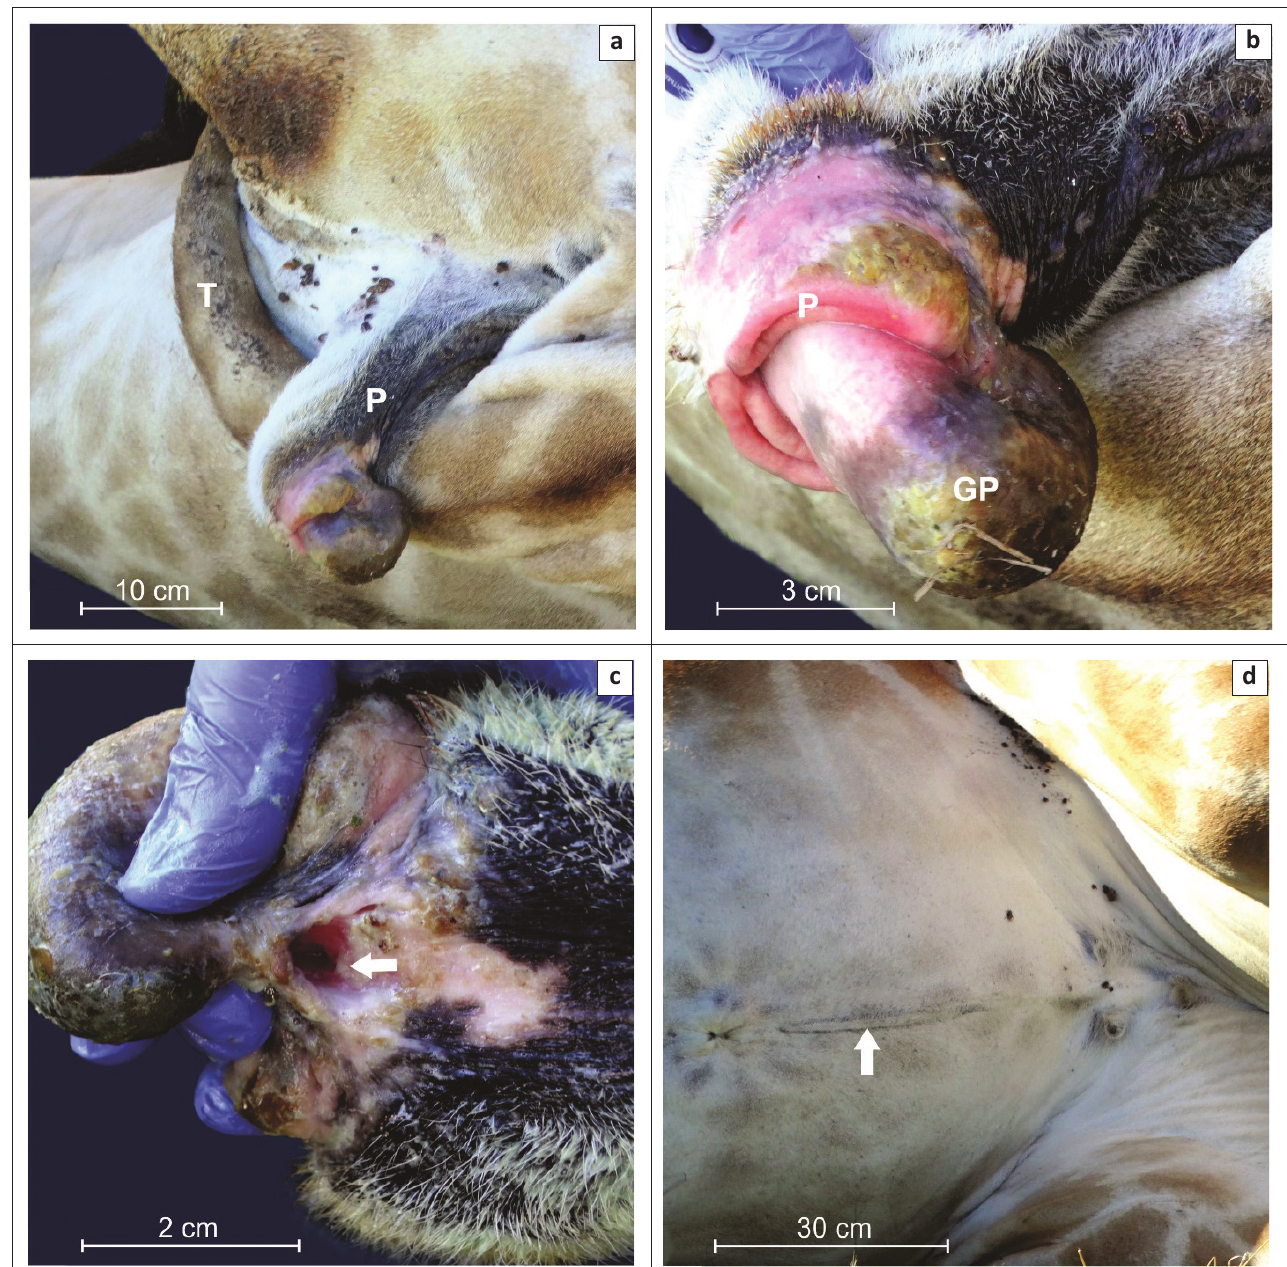
FIGURE 1: Macroscopic appearance of external genitalia in a giraffe. See tail (T) for orientation of the penis (P) (a). Closer view (b), with structures identified as the prepuce (P) and head of the penis (glans penis, GP). Note the urethral opening (arrow) at the dorsal aspect of the distal penis (c) and the skin depression (arrow) on the ventral midline caudal to the umbilicus